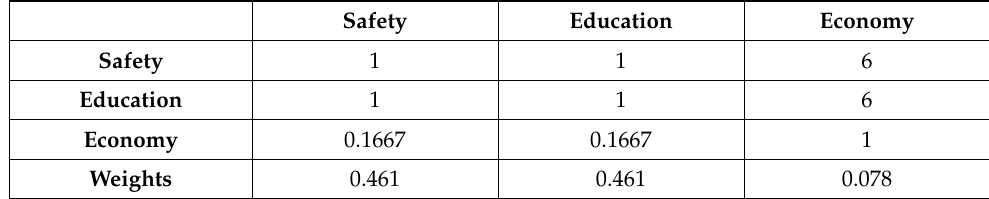
Table 18. Pairwise Comparison Matrix for Mo.